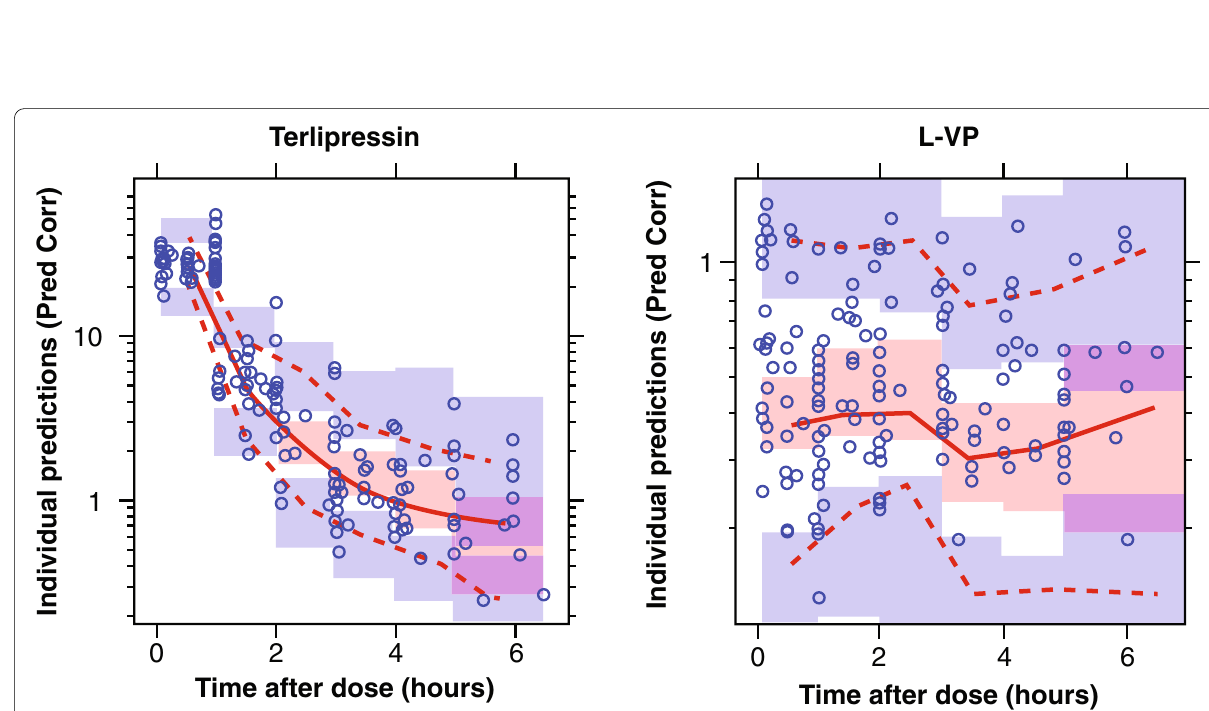
Fig. 3 Visual predictive check: model-predicted and observed plasma concentrations of terlipressin and L-VP in patients with HRS. Blue circle markers represent observed PK data; solid red line represents the median observed values; solid red areas indicate the model-predicted 90% confidence interval for the median. The 2.5th and 97.5th percentiles of observed data are presented with dashed red lines, and the blue solid areas represent the model-predicted 90% confidence intervals for the corresponding percentiles. HRS , hepatorenal syndrome; L-VP , lysine-vasopressin; PK